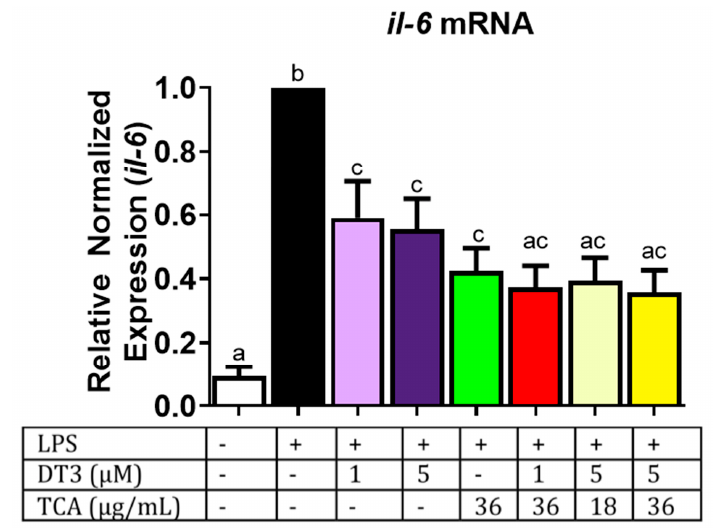
Figure 4. Delta-tocotrienol and tart cherry anthocyanins decrease pro-inflammatory cytokine IL-6 : DT3 and TCA individually and in combination significantly reduced expression of Il-6 . Means with different letters (a, b, c) are significant. n = 6, p < 0.05.